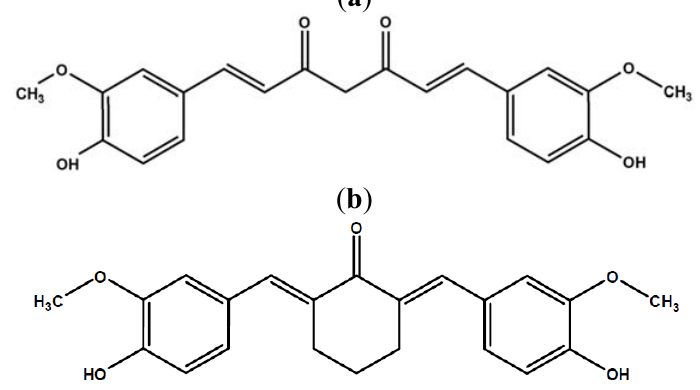
Figure 1. Chemical structures of ( a ) curcumin and ( b ) 2,6-bis-(4-hydroxy-3- methoxybenzylidene)-cyclohexanone (BHMC). ( a )